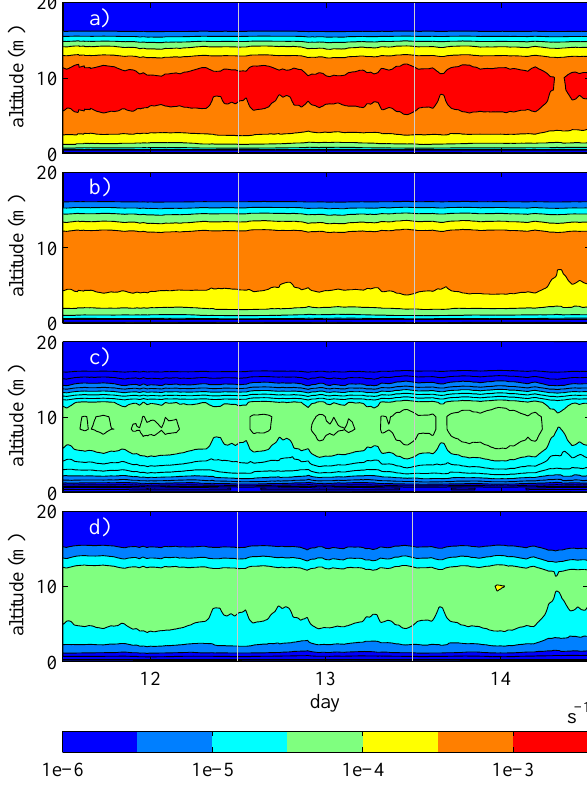
Fig. 6. Effect of turbulent flux on (a) 3–6nm (b) 3–25nm, (c) 25– 100nm and (d) 100–1000nm particle concentration calculated as − dF t /dz . Black solid curve represents simulated mixing height.